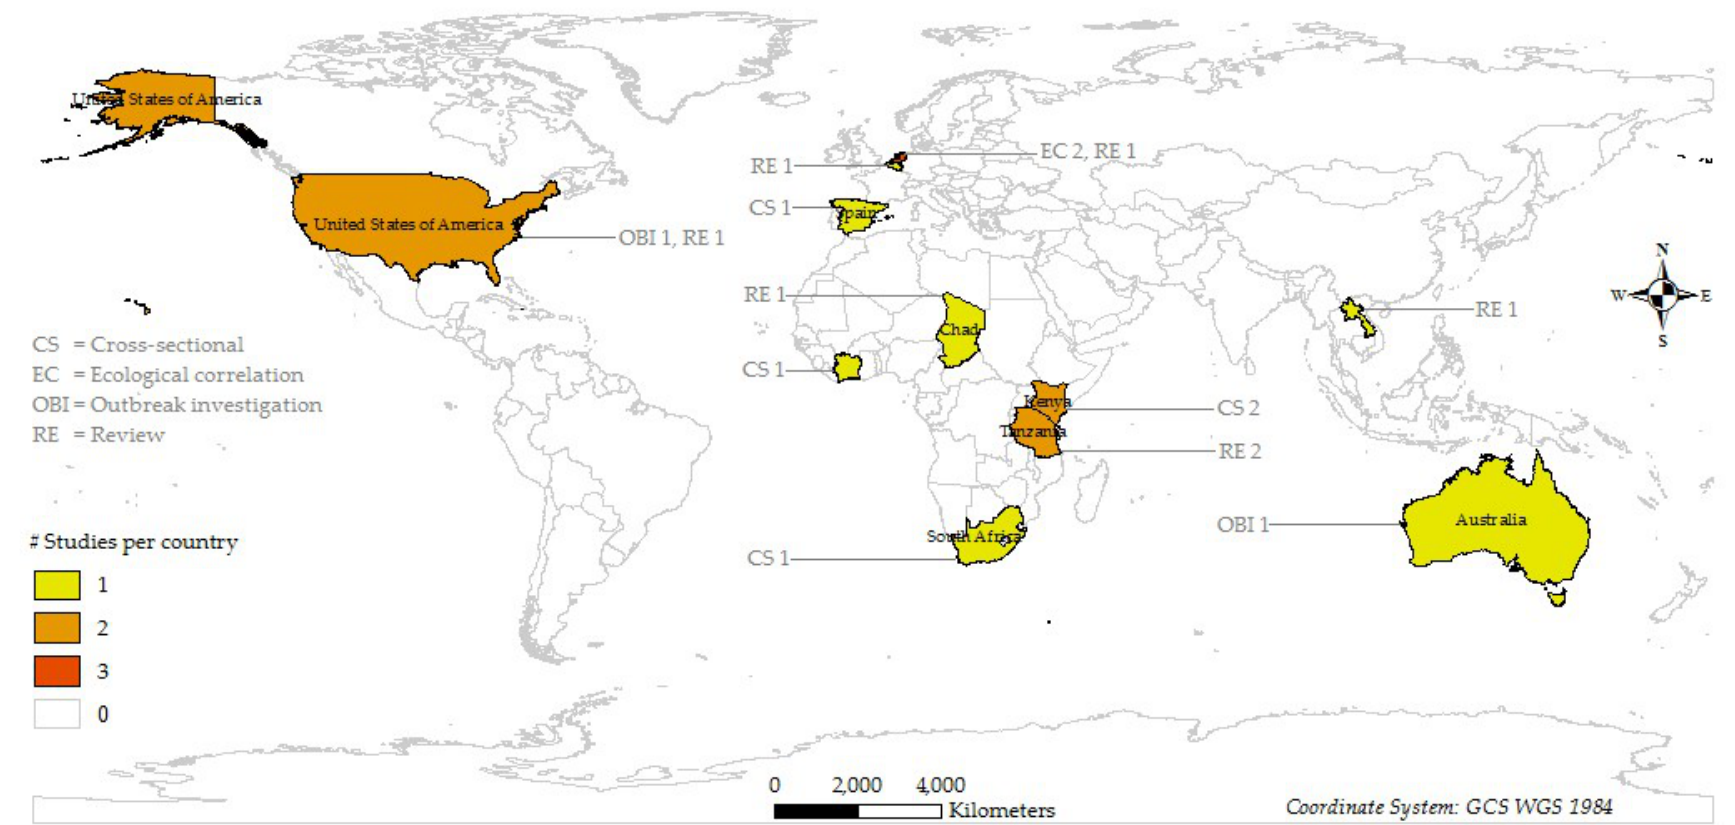
Figure 2. Distribution of studies that used a One Health approach to Q fever by location and study design.